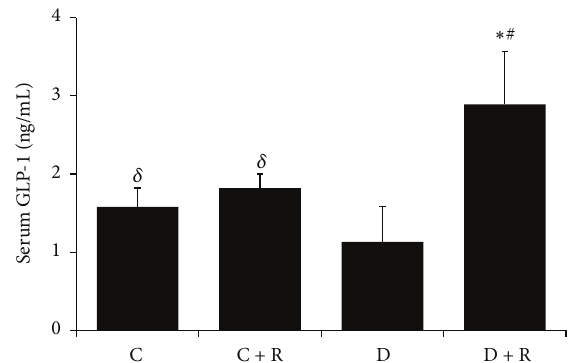
Figure 2: Serum GLP-1 level in four groups. ∗ 𝑃 < 0.01 compared with D group; # 𝑃 < 0.01 compared with C group; 𝛿 𝑃 < 0.05 com- pared with D group.